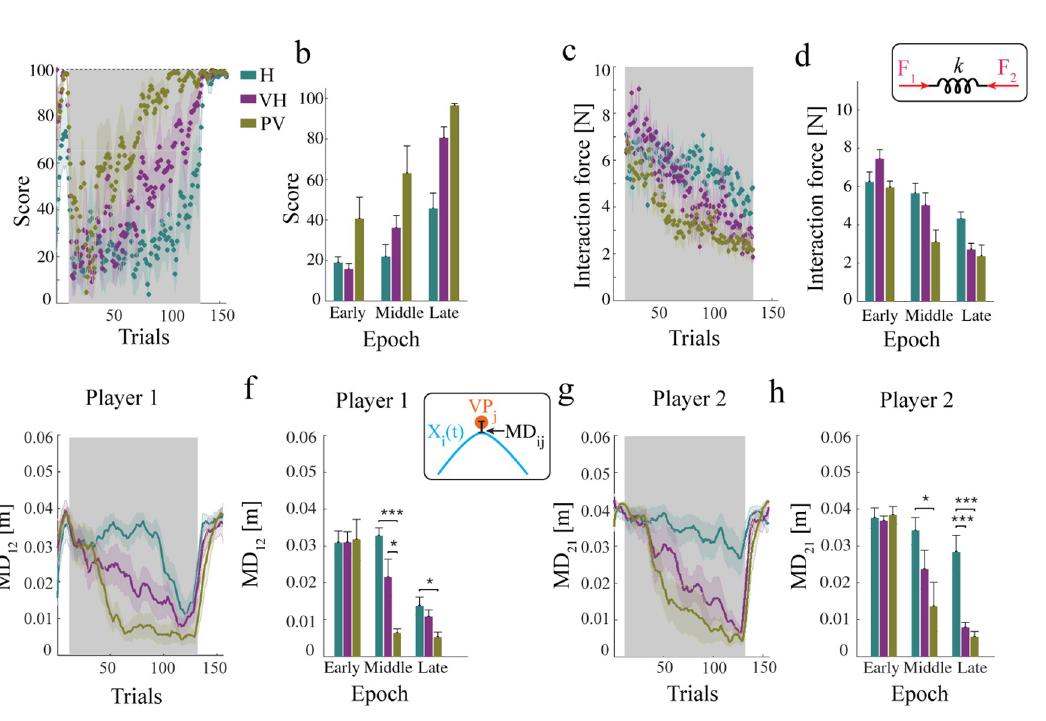
Fig 2. Dyads develop a collaboration, and learning depends on the amount of information available about the partner. (a) Temporal evolution of score over trials, for the haptic (H), visuo-haptic (VH) and partner-visible (PV) groups respectively. (b) Score at the beginning, middle and at the end of training. (c) Magnitude of the average interaction force over trials. (d) Interaction force at the beginning, middle and at the end of training. (e) , Magnitude of the distance from partner’s VP for Player 1 over trials for the H, VH and PV groups. (f) Minimum distances of Player 1 from his/her partner’s VP at the beginning, middle and at the end of training. (g,h) , As in (e,f) for Player 2. The areas in grey denote the training phase. All plots indicate the population means. Error bars and shaded areas denote the standard error (SE). Asterisks indicate statistically significant differences ( � P < 0.05, �� P < 0.01, ��� P <